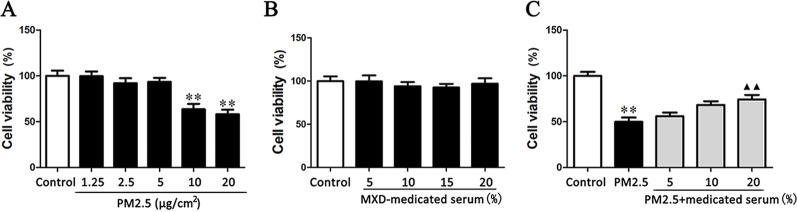
Effects of PM2.5 and MXD-medicated serum on the cell viability of RAW 264.7 after a 24-hour incubation. (A) The cytotoxic effects of PM2.5 on RAW 264.7 cell viability. (B) The confirmation for the non-cytotoxic concentrations (volume fractions) of MXD-medicated serum. (C) Protective effect of MXD-medicated serum on RAW 264.7 exposed to PM2.5. Data are expressed as mean ± SEM, n = 6. **p < 0.01 vs. Control group; ▴▴
p < 0.01 vs. PM2.5 group.